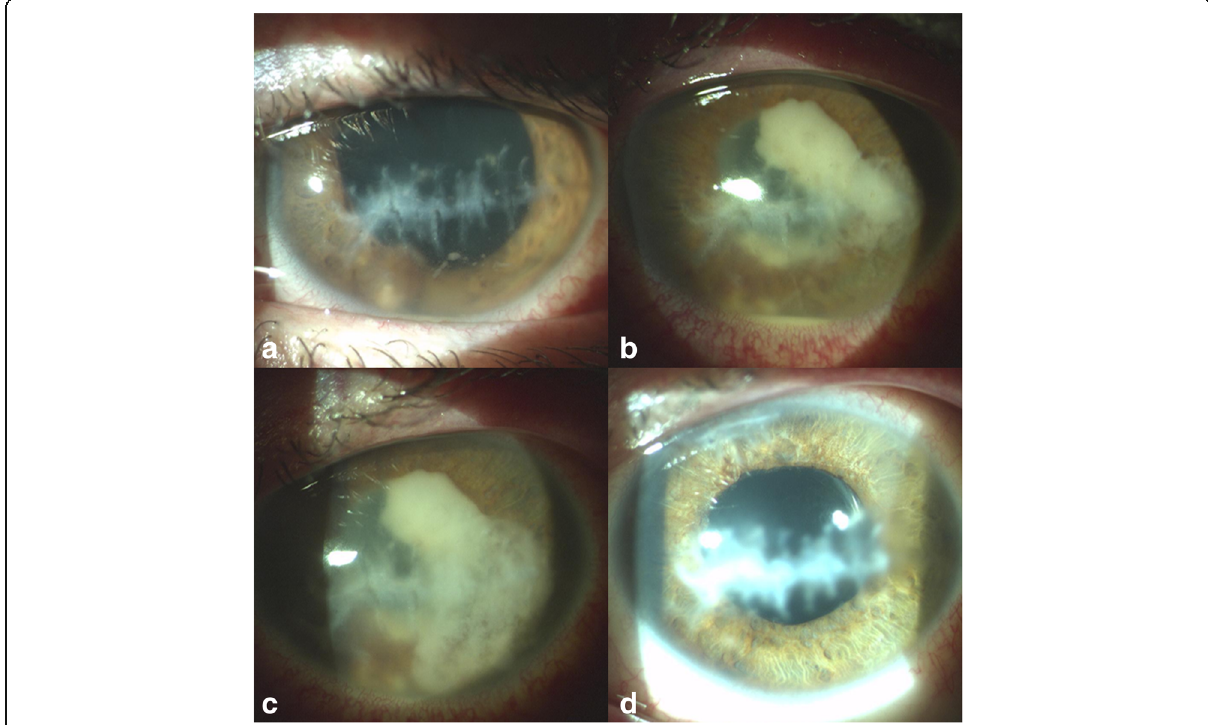
Fig. 1 Post-traumatic corneal scar. Mild non-granulomatous anterior uveitis with fibrin in the anterior chamber. The nodular exudates grew anteriorly towards the corneal endothelium and imitated an iris cyst ( a ). A hypopyon in the anterior chamber and white, plump, fluffy hemispherical exudates progressing into the anterior chamber ( b ). Whitish, plump, nodular, and tufted exudates continued to develop within the anterior chamber ( c ). The eye 5 years after cataract surgery. The eye is completely without signs and symptoms of inflammation and the patient is without any local and systemic medications ( d